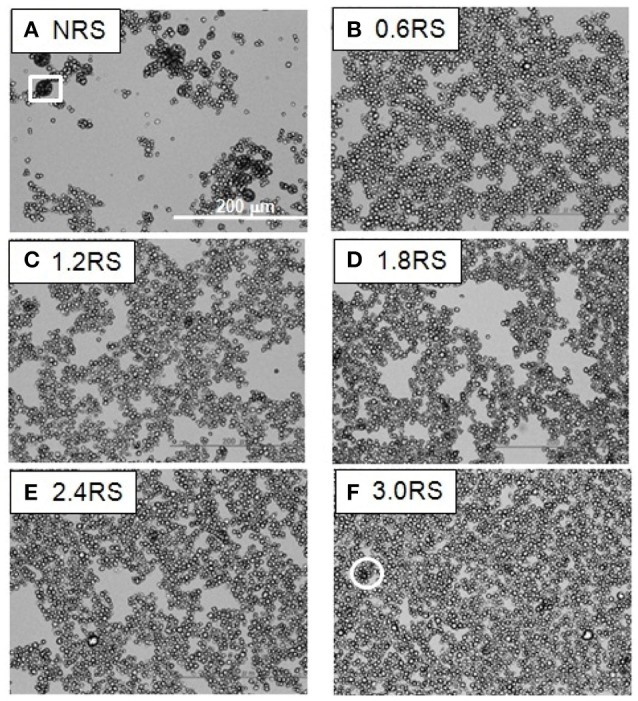
Optical microscope images of films of native and OSA modified starch particles compressed to ∏ = 5 mN/m at air/water interfaces. The white square shows an example of the large aggregates formed by the NRS particles. The white circles show examples of dark patches of closely packed OSA modified particles or aggregates in the films.